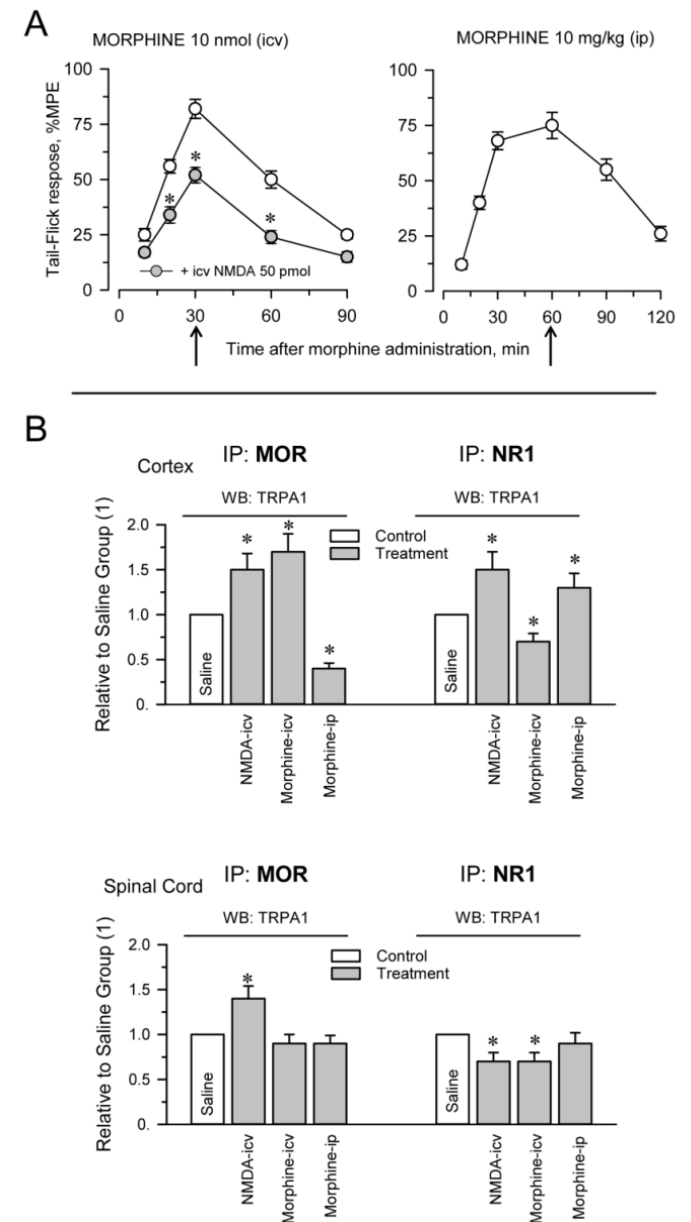
Figure 2. Pharmacological modulation of TRPA1 associations with MORs and glutamate NMDARs. Different groups of mice were icv-injected with saline, 50 pmol NMDA and 10 nmol morphine. Another group of mice received 10 mg/kg morphine via the ip route. ( A ) Antinociception promoted by morphine was determined in the warm water tail-flick test and is shown as a time-course. The effect of NMDA is shown relative to its antagonism of icv morphine analgesia. The points are the mean ± SEM from groups of six mice. * Significant differences with respect to the group that received only morphine icv, p < 0.05. ( B ) Effect of pharmacological interventions on the associations of TRPA1 with MORs and NR1 subunits. Thirty minutes after the icv injections and 60 min after ip morphine (indicated by the arrows), the mice were killed and cortical and spinal cord synaptosomal fractions were prepared. Following solubilization of these membrane preparations, MORs and NR1 subunits were immunoprecipitated. The coprecipitated TRPA1 was detached from the bait proteins and the presence of the monomer was analyzed by Western blotting. For each association and structure, namely, the cerebral cortex and spinal cord, the data were referred to the control group that received saline and was assigned an arbitrary value of 1. The bars are the mean ± SEM from two or three determinations. * Significant differences with respect to the control group, p < 0.05. Further details in Supplementary Materials Figure S4 and the Section 4.